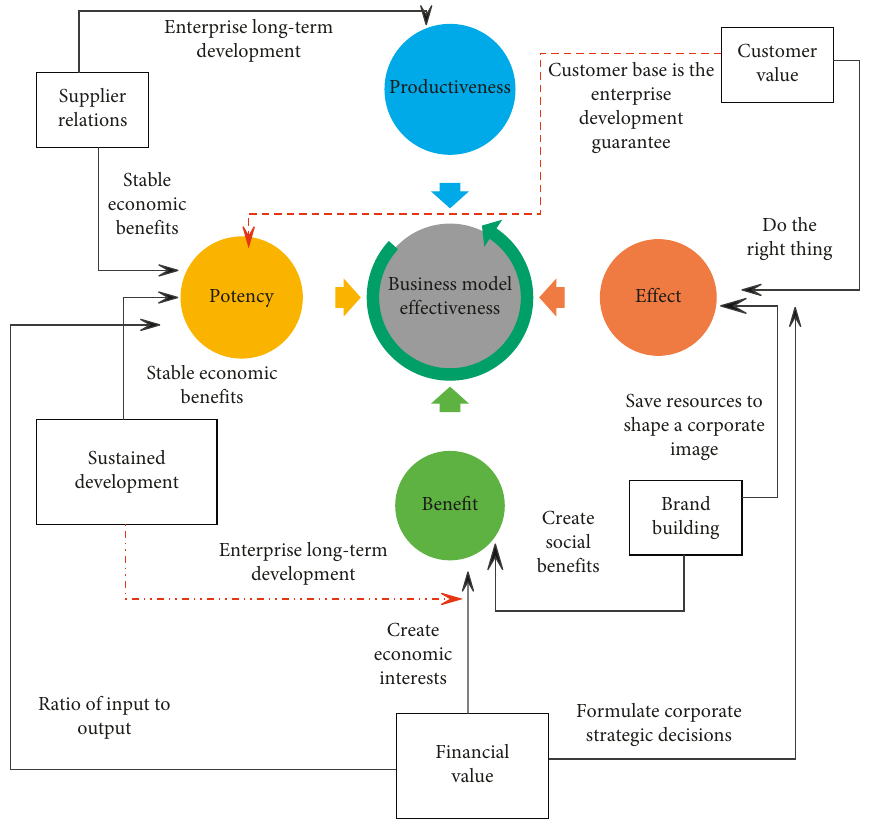
Figure 5: Modification of the mechanism of the effectiveness of the technological startups business model.